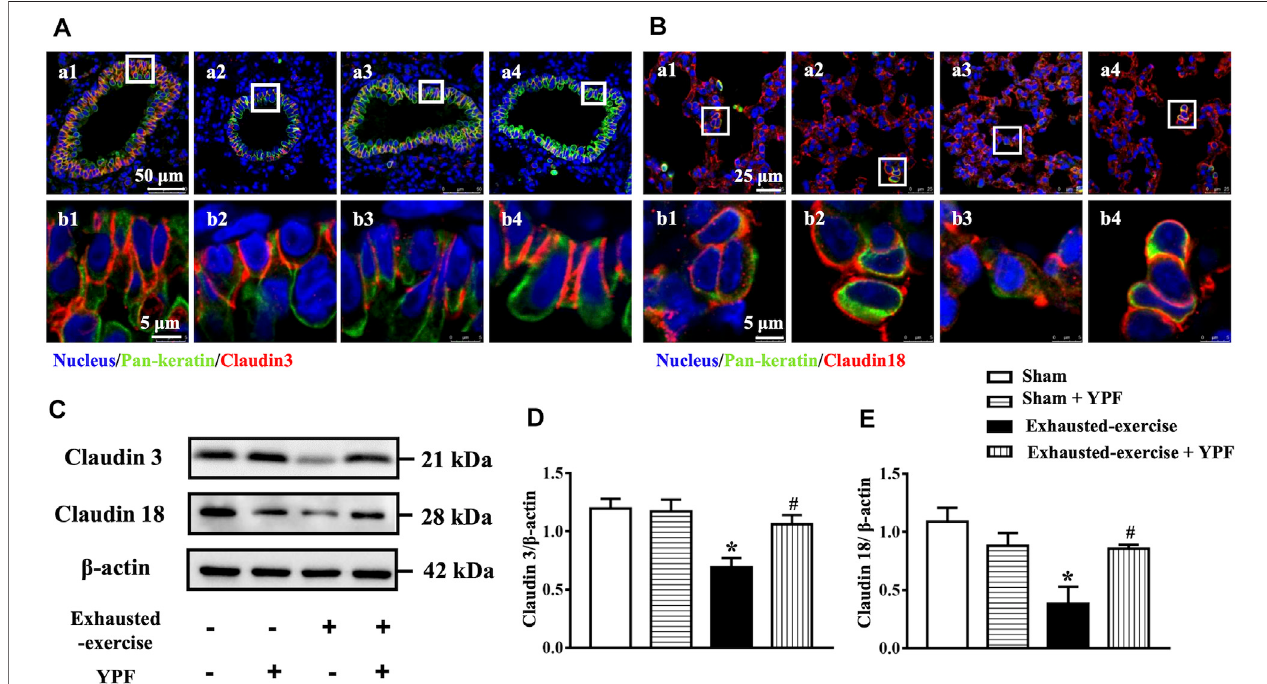
FIGURE 3 | YPF maintainsthe integrity of cell junctions in the pulmonary epithelium. (A) Representative immuno fl uorescent staining images of claudin 3 in the lung tracheal epithelium. Claudin 3 (red) localized between the epithelial cells with marker E-cadherin (green). Nuclei stained blue. (a1, b1) Sham group; (a2, b2) sham + YPF group; (a3, b3) exhausted-exercise group; and (a4, b4) exhausted-exercise + YPF group. Upper scale bar = 50 μ M; lower scale bar = 5 μ M. (B) Representative immuno fl uorescentstainingimagesofclaudin18inthealveolarepithelium.Claudin18(red)localizedbetweentheepithelialcellswithmarkerE-cadherin(green)and nuclei stained blue. (a1, b1) Sham group; (a2, b2) sham + YPF group; (a3, b3) exhausted-exercise group; and (a4, b4) exhausted-exercise + YPF group. Upper scale bar=25 μ M;lowerscalebar=5 μ M. (C) RepresentativeWesternbandsofclaudin3andclaudin18. β -Actinwasusedasaloadingcontrol; n =4. (D – E) DepictedinDand Earethesemiquantitativeanalysesofclaudin3andclaudin18,respectively.Resultsarepresentedasmeans±SEM( n =4). * p < 0.05vs.sham;# p < 0.05vs.exhausted-